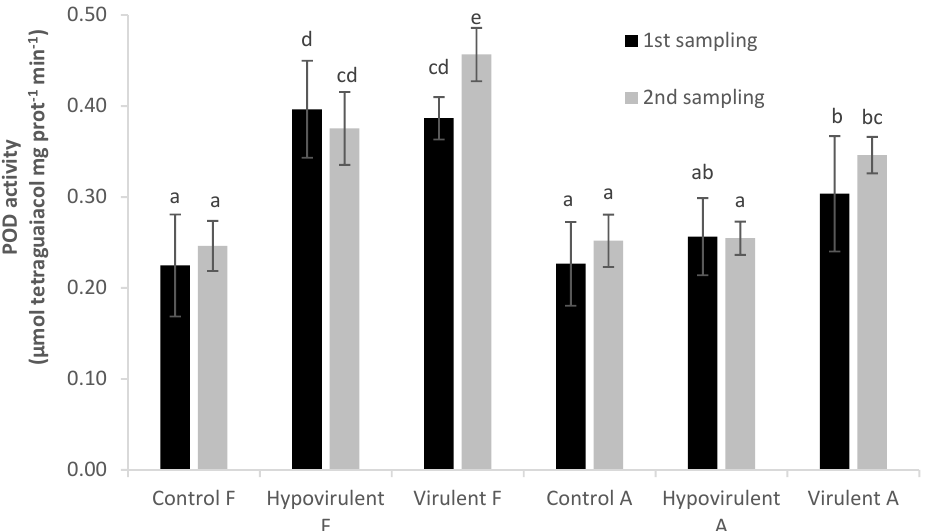
Figure 5. POD activity in chestnut leaves 21 and 42 days after Cryphonectria parasitica infection. Values are means ± SD, n = 5. Significant differences among samples based on the Tukey-HSD test. The results of ascorbate peroxidase (APX) activity also show that the values